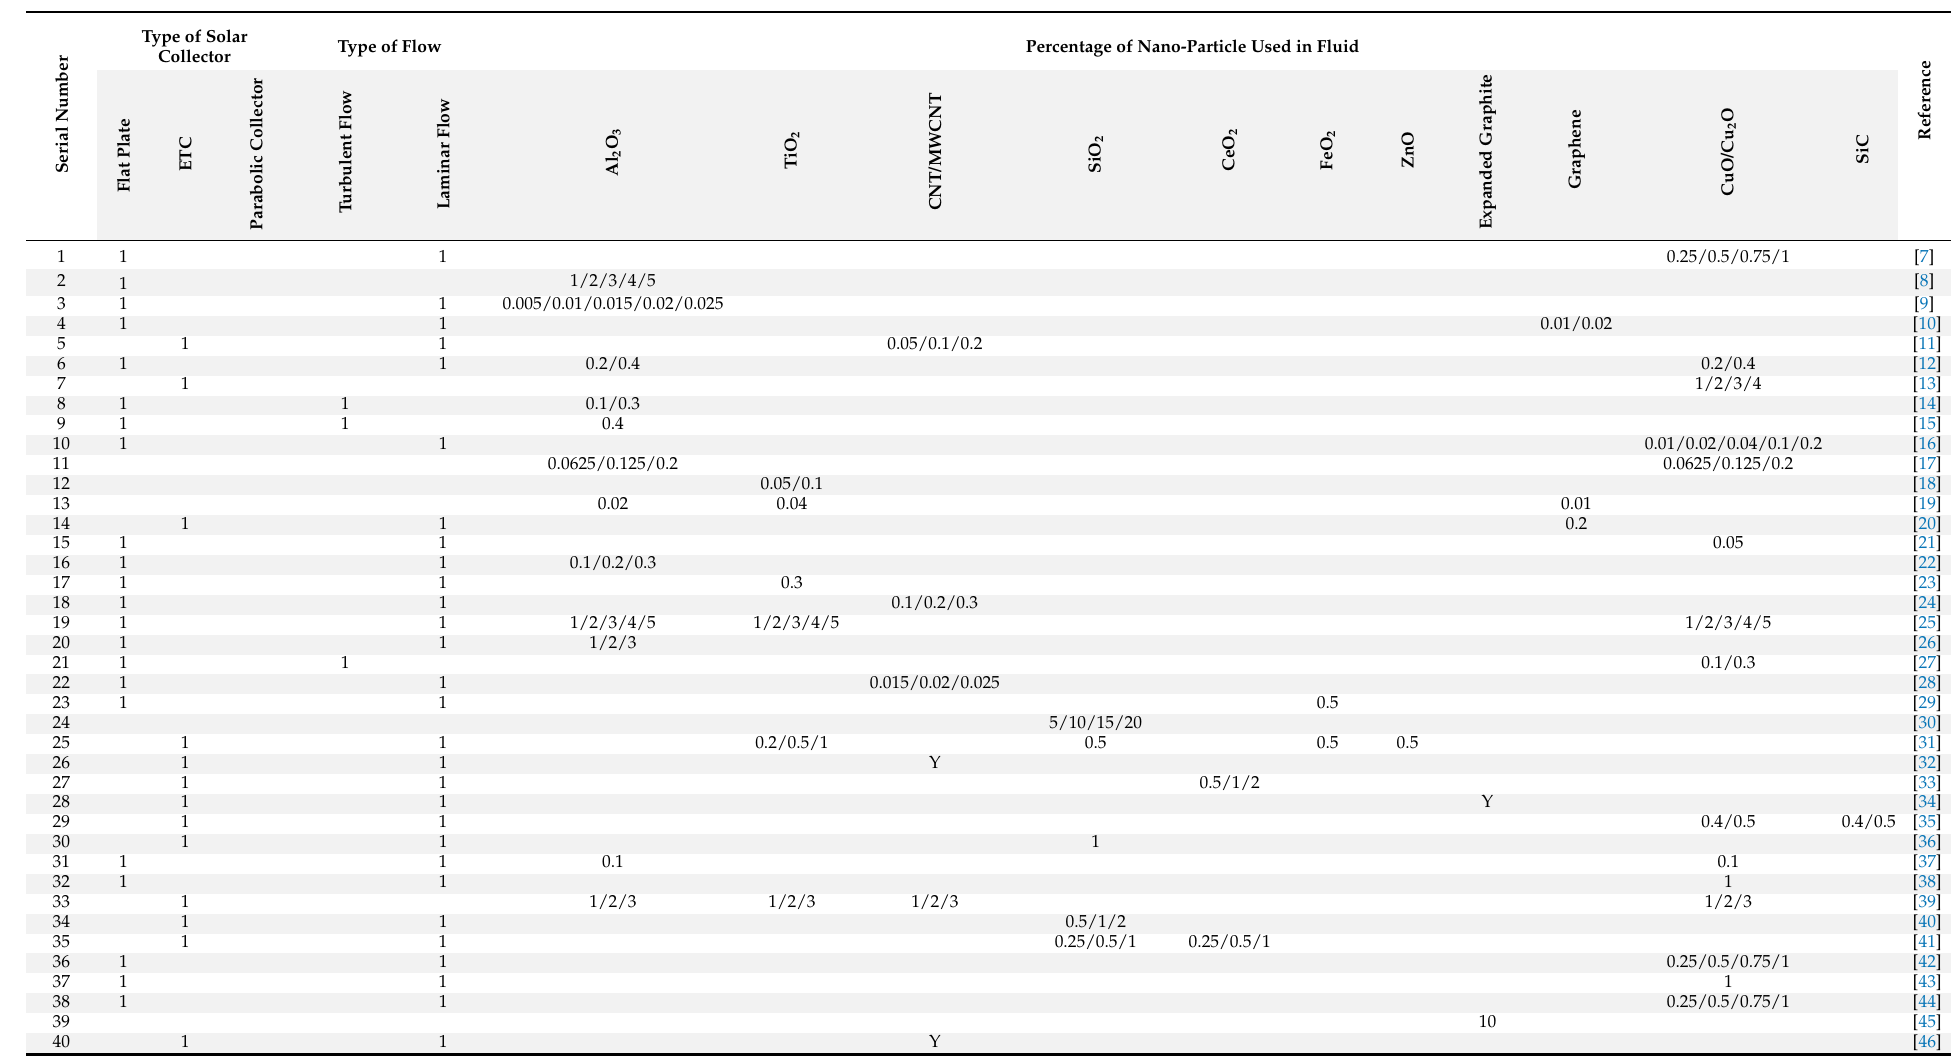
Table 3. Application of nanoparticles (with concentration) in solar water heating applications